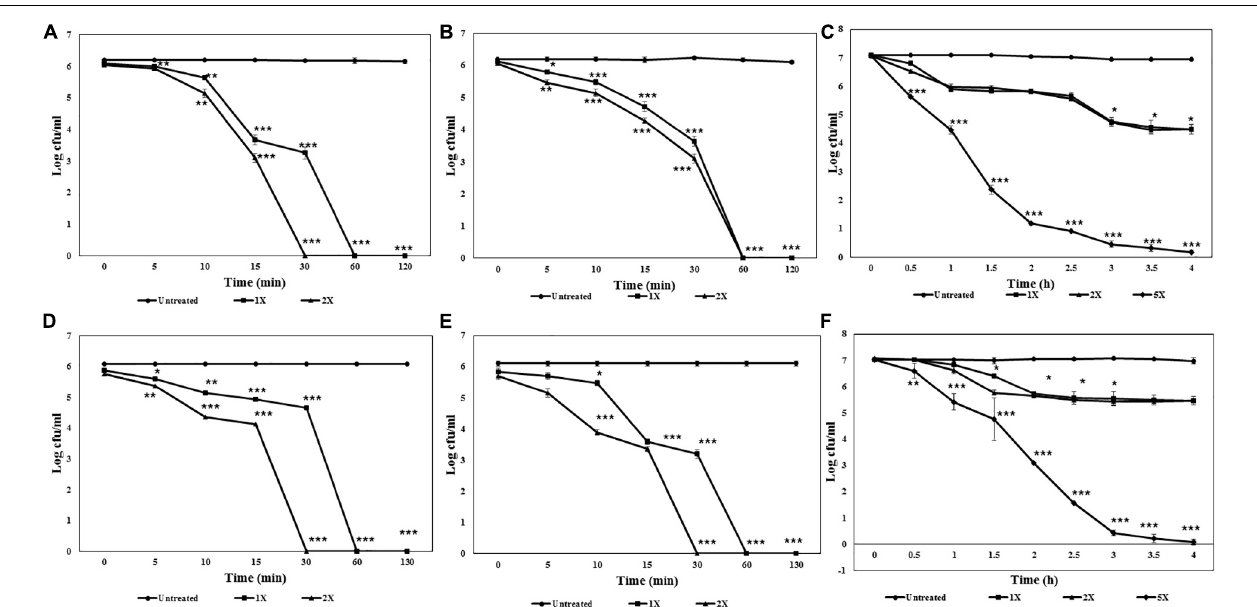
FIGURE 3 | Killing kinetics of antimicrobial lipopeptides. (A) ILL against S. aureus MTCC 1430. (B) ILL against V. cholerae MTCC 3904. (C) ILL against C. albicans MTCC 1430. (D) BLL against S. aureus MTCC 1430. (E) BLL against V. cholerae MTCC 3904. (F) BLL against C. albicans MTCC